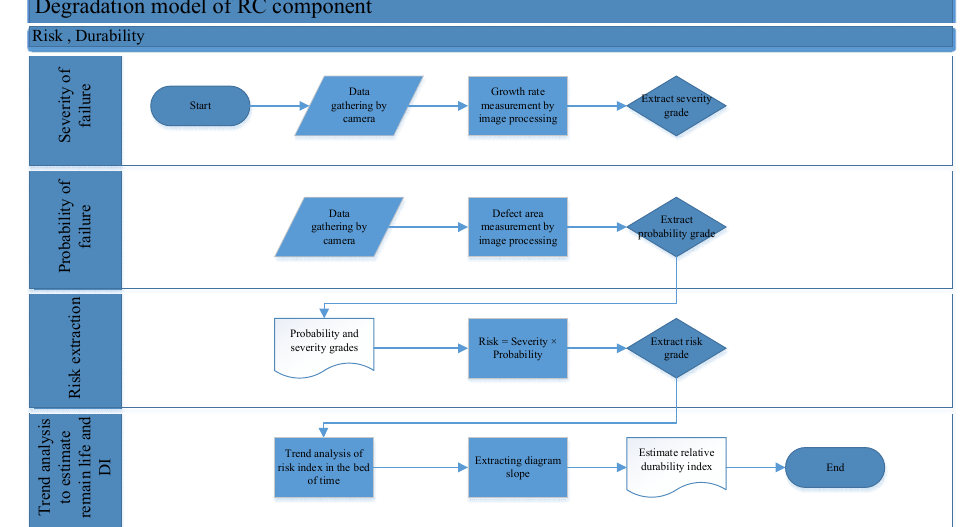
Figure 2. Research method.